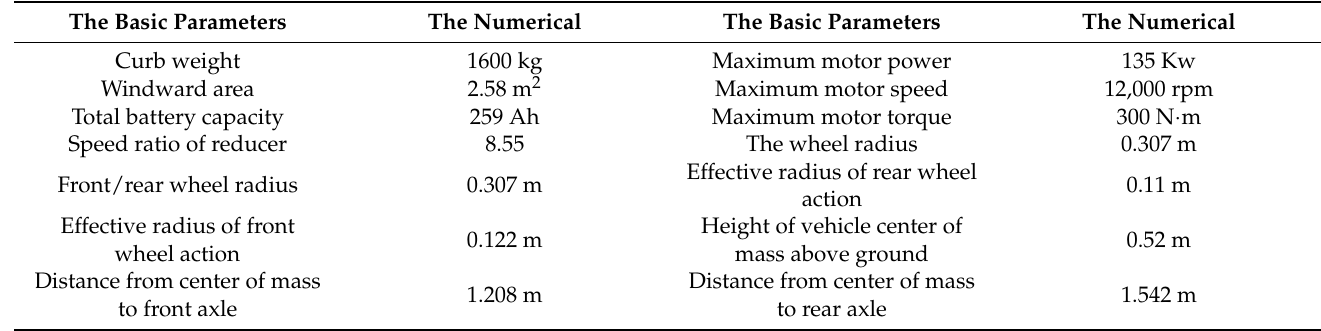
Table 2. The basic parameters of